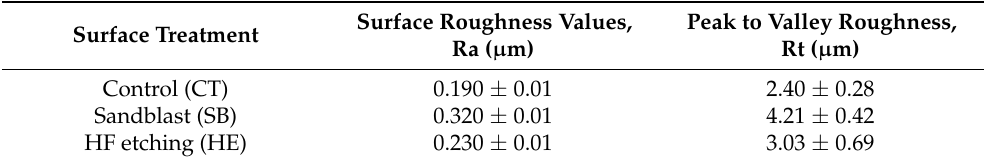
Table 2. Surface roughness (Ra, μ m) and peak-to-valley roughness (Rt, μ m) of control, SB and HE (mean ± standard deviation).